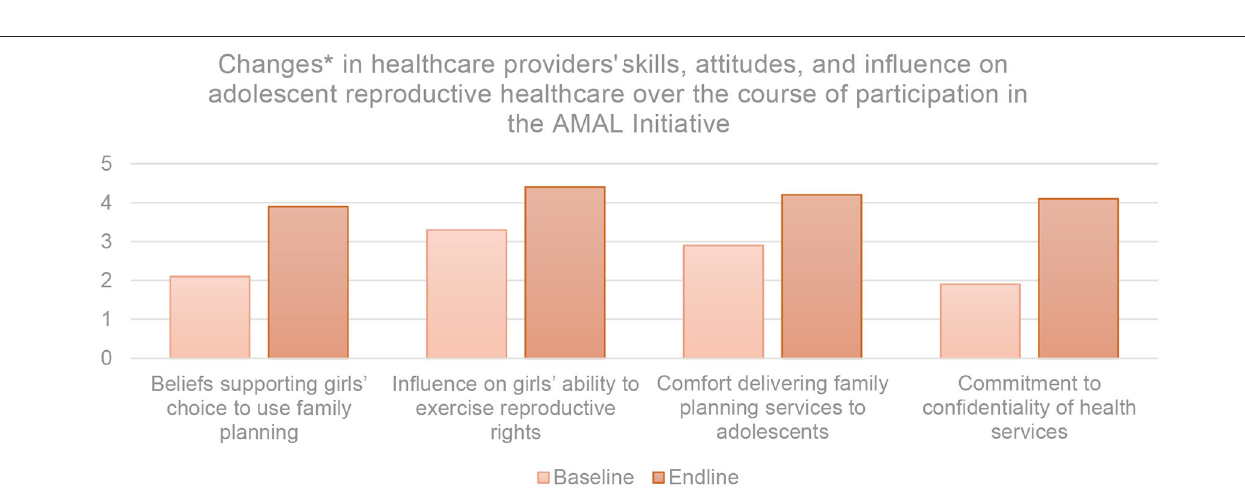
FIGURE 3 | Consolidated changes between baseline and end line in AMAL community participants’ self-report of attitudes toward and norms related to gender and reproductive health norms on a five-point Likert Scale. *Measured through a consolidated analysis of norms statements using five-point Likert Scale wherein 1, strongly disagree; 2, disagree; 3, neutral; 4, agree; and 5, strongly agree.